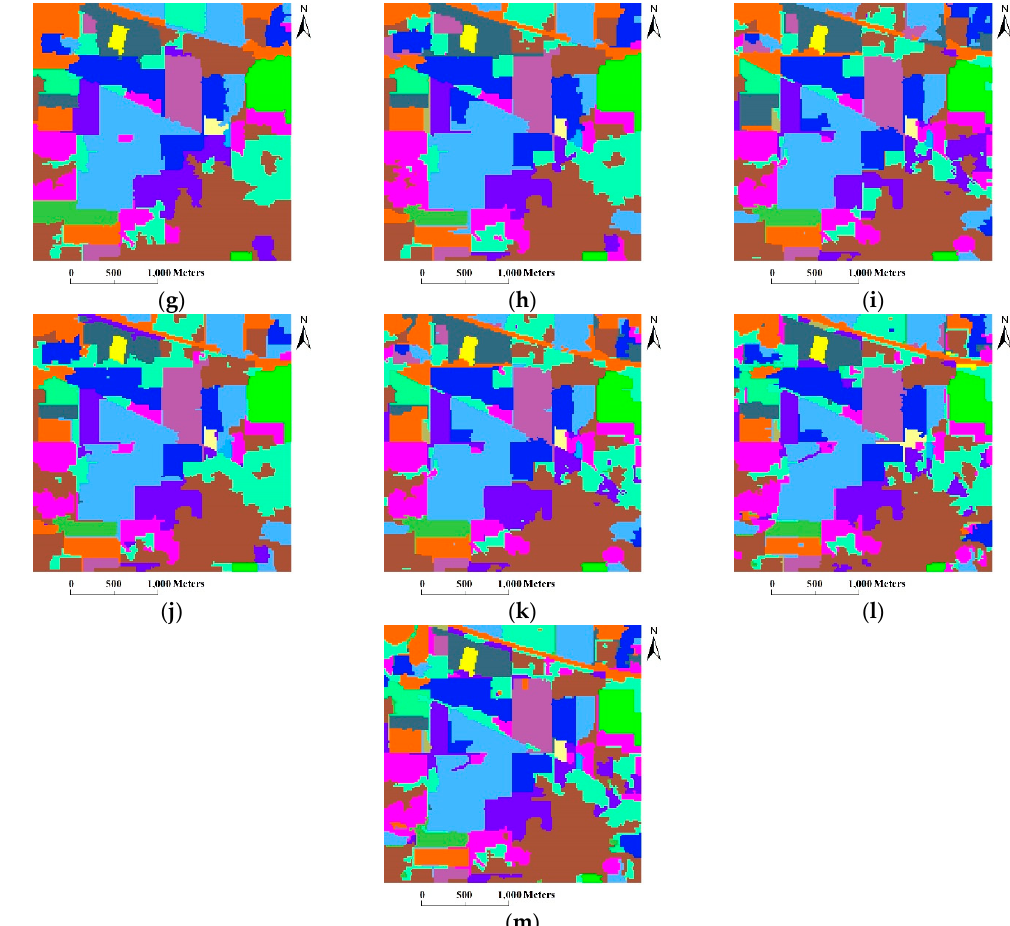
Figure 7. Classification maps for the Indian Pines image: ( a ) RGB composite (bands 47, 23, and 13); ( b ) Ground truth data; ( c ) SVM; ( d ) Proba-M-HSEG; ( e ) Proba-M-HSEG +MV; ( f ) Morph-M-HSEG; ( g ) Morph-M-HSEG +MV; ( h ) Proba-M-MSF using ED; ( i ) Proba-M-MSF using SAM; ( j ) Proba-M-MSF